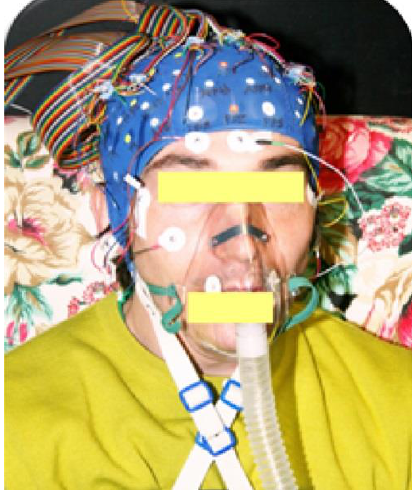
Figure 2. A picture of a participant wearing the mask connected to the hypoxicator apparatus which provided air impoverished of a 12.5% of oxygen during the electroencephalogram (EEG) recording session.